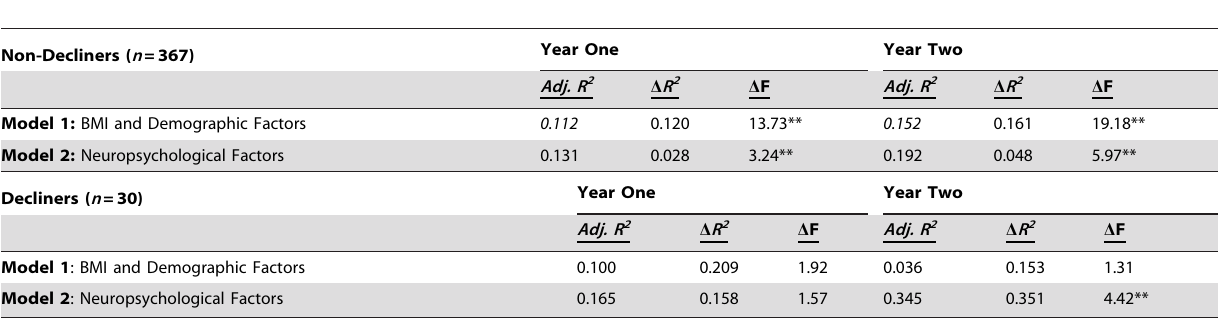
Table 5. Contribution of Demographic and Neuropsychological Factors to Dual Task Step Time by Group and Year.